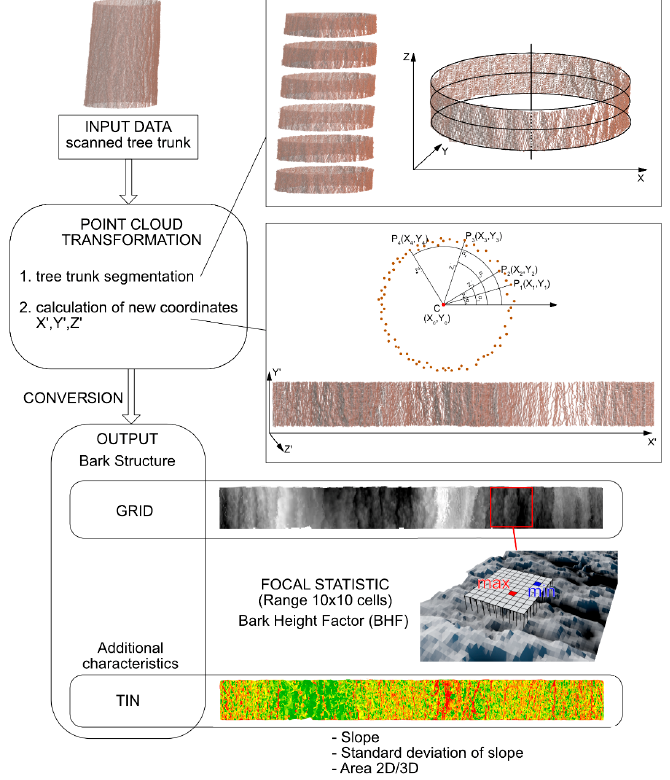
Figure 2. The scheme of TTBSM processing.